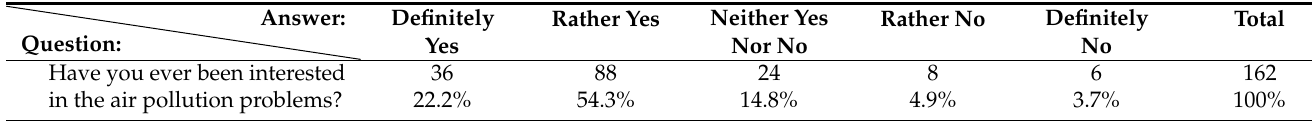
Table 3. Students’ interests in air pollution